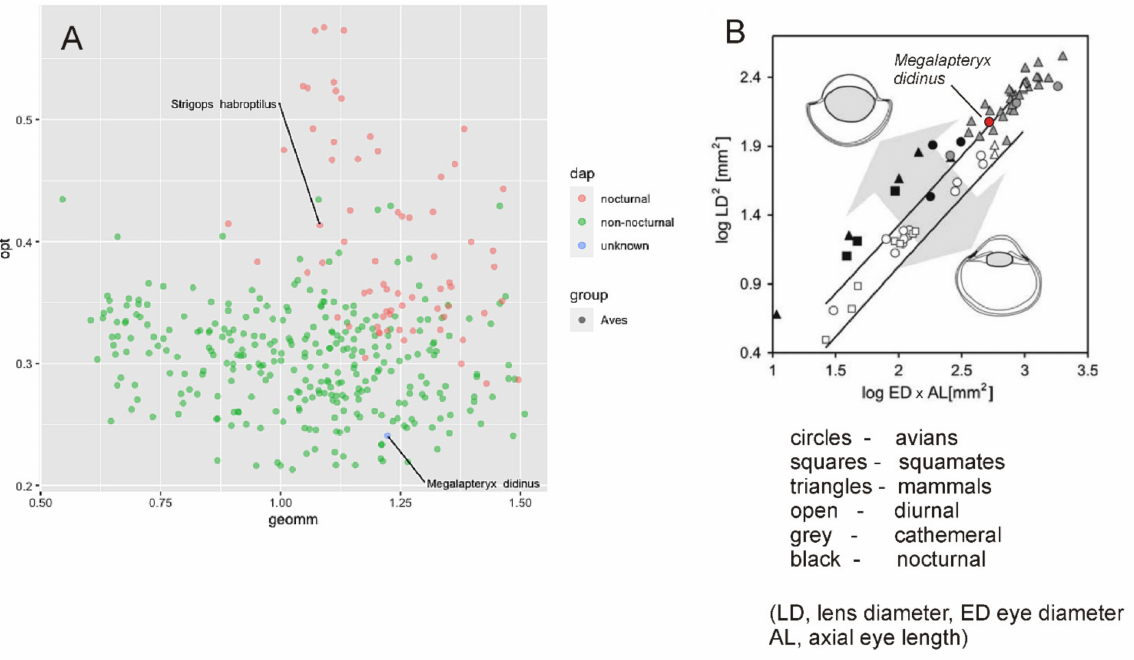
Figure 7. ( A ) plot of optic ratio (opt) against geometric mean of eye measurements (geomm). dap,daily activity pattern. ( B ) plot reproduced with permission from [37], with Megalapteryx didinus